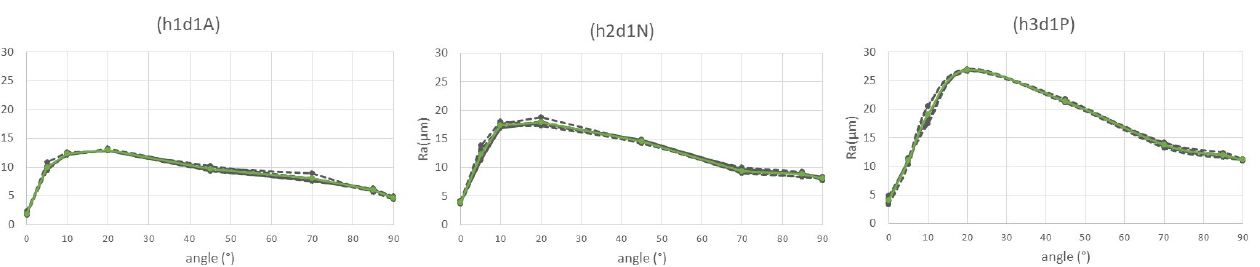
Figure 5. Ra values measured on eight angles of specimens h3d1PLA, h3d2ABS and h3d3 nylon. Standard deviations were also reduced, with the exception of occasional cases where models were not clearly defined and had values that reached a maximum of 1.45 µm (Fig- ure S2). Initially, it was expected that due to the predictable roughness value in the horizontal plane (0°), it would increase up to the maximum value in the vertical plane, since this angle (90°) should have presented greater deviations when the roughness measurement was perpendicular to the deposition plane and to the elliptical section considered, always showing a greater depth in the spaces generated between layers. However, once the re- sults were analyzed, in all cases studied, which were very different from each other, shape relationship values between nozzle diameter and layer height of 1.67 up to 13.33 were achieved, and a maximum roughness value of 20° was obtained, regardless of the combi- nation of layer height, nozzle diameter and material (Figure 6, Figure 7, Figures S3–S5 and Table S7).